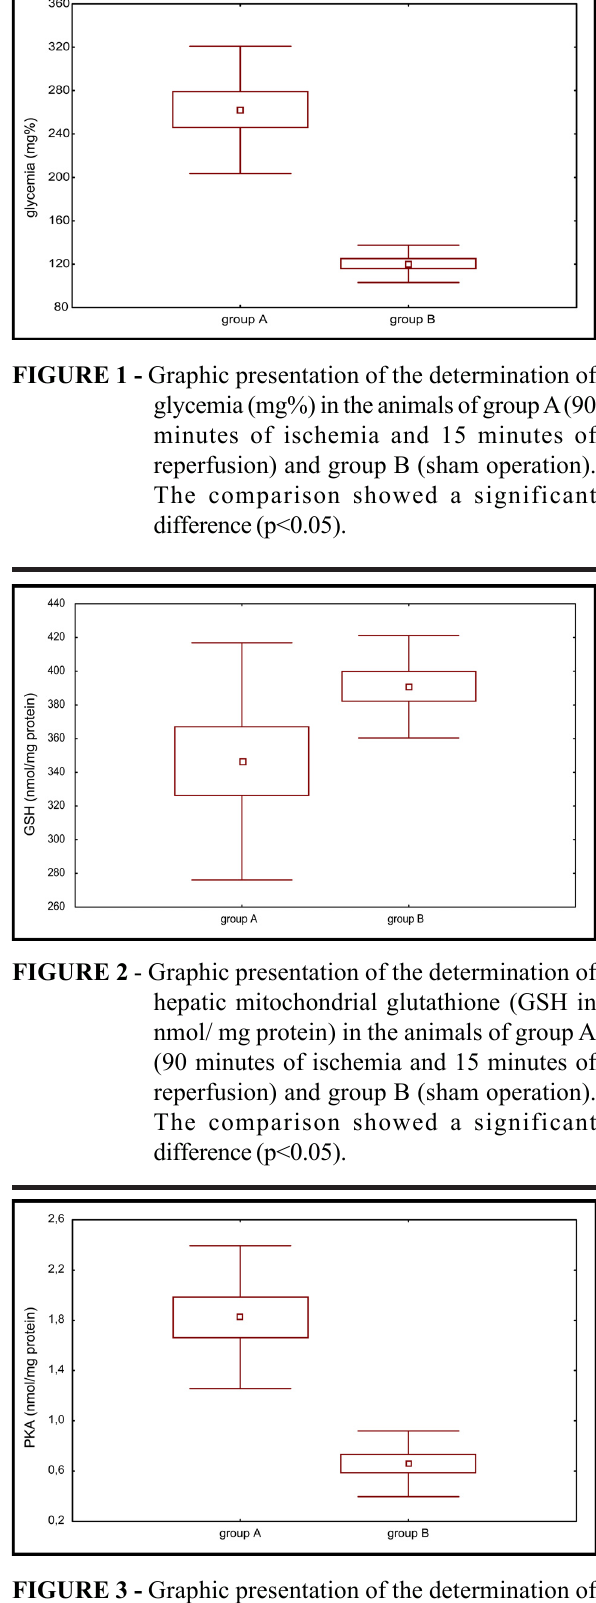
FIGURE 3 - Graphic presentation of the determination of hepatic tissue pyruvate kinase activity (PKA) in the animals of group A (90 minutes of ischemia and 15 minutes of reperfusion) and group B (sham operation). The comparison showed a significant difference